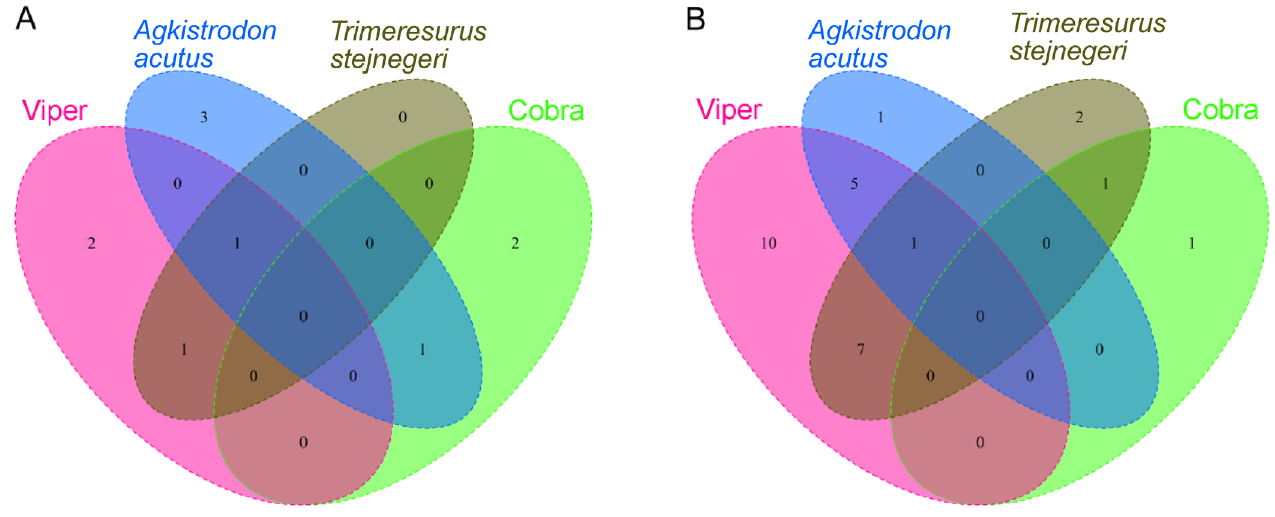
Figure 2. Venn diagrams depicting the distribution of upregulation and downregulation of the 38 differential abundance proteins (DAPs) with statistical significance. (A) The overlap of significantly upregulated protein in the four snakebite subgroups as compared to the healthy control group. (B) The overlap of significantly downregulated proteins in the four snakebite subgroups as compared to the healthy control group.